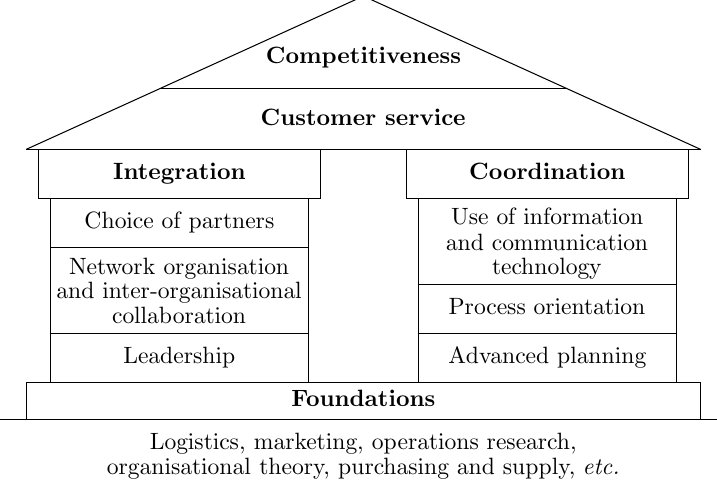
Figure 1: The house of